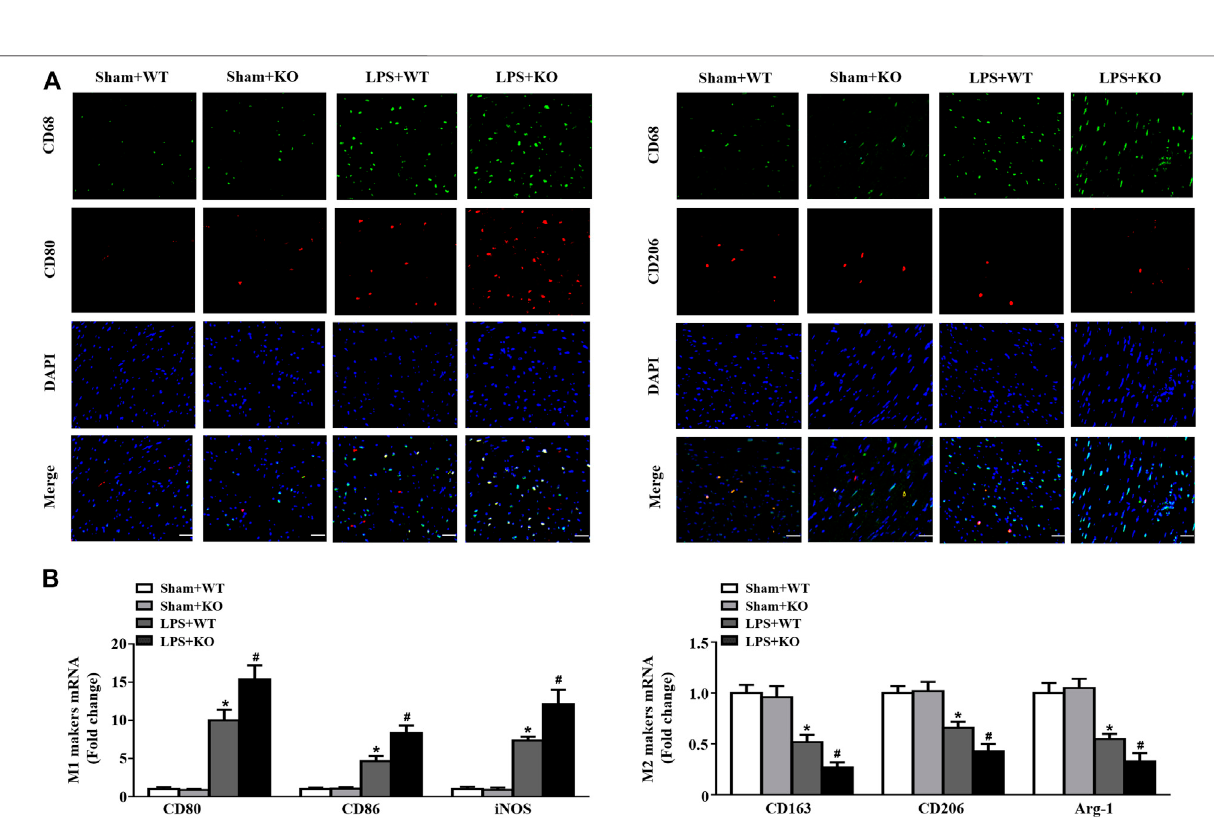
Frontiers in Pharmacology |